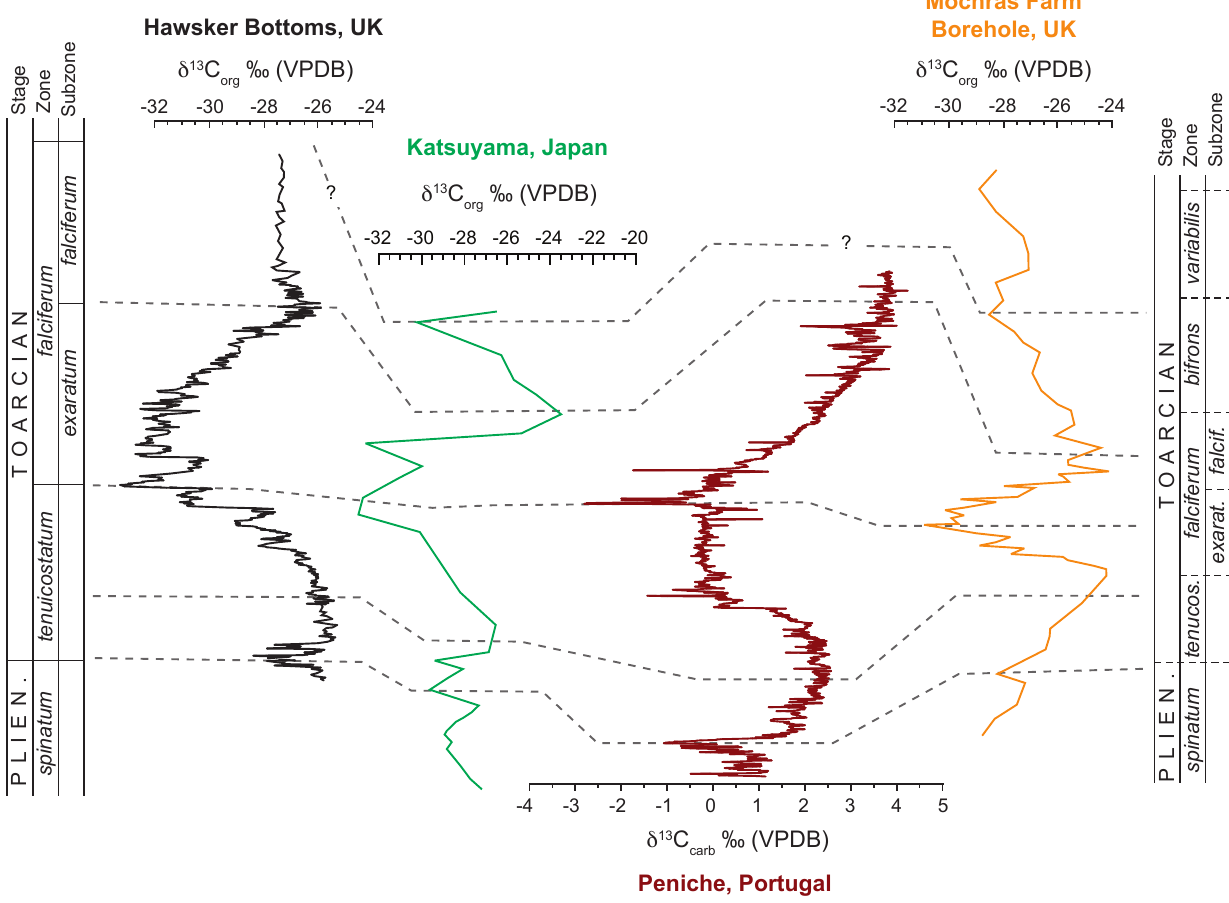
Fig. 6. Comparison of δ 13 C profiles for the Plienbachian–Toarcian time interval. Bulk-sediment data are compiled from Whitby (dataset is from both Port Mulgrave and Hawsker Bottoms) (Kemp et al., 2005; Littler et al., 2009), Katsuyama (this study), Peniche (Hesselbo et al., 2007) and Mochras Farm Borehole (Jenkyns et al., 2001). The δ 13 C profiles have been correlated using the negative excursion at the Pliensbachian/Toarcian boundary, positive values in the lower Toarcian, the negative values in the T-OAE, the subsequent positive excursion after the T-OAE, and finally the negative trend in the bifrons ammonite Zone between Mochras Farm Borehole and Katsuyama. Note that Peniche is the only carbonate carbon isotope record. This chemostratigraphic correlation of Toarcian successions suggests that the biostratigraphic scheme using Carter et al. (2010) is more relevant when not considering the presence of H. exiguum at ca. 100cm (sensu Hori, 2011) and the lack of other key species indicative of the middle